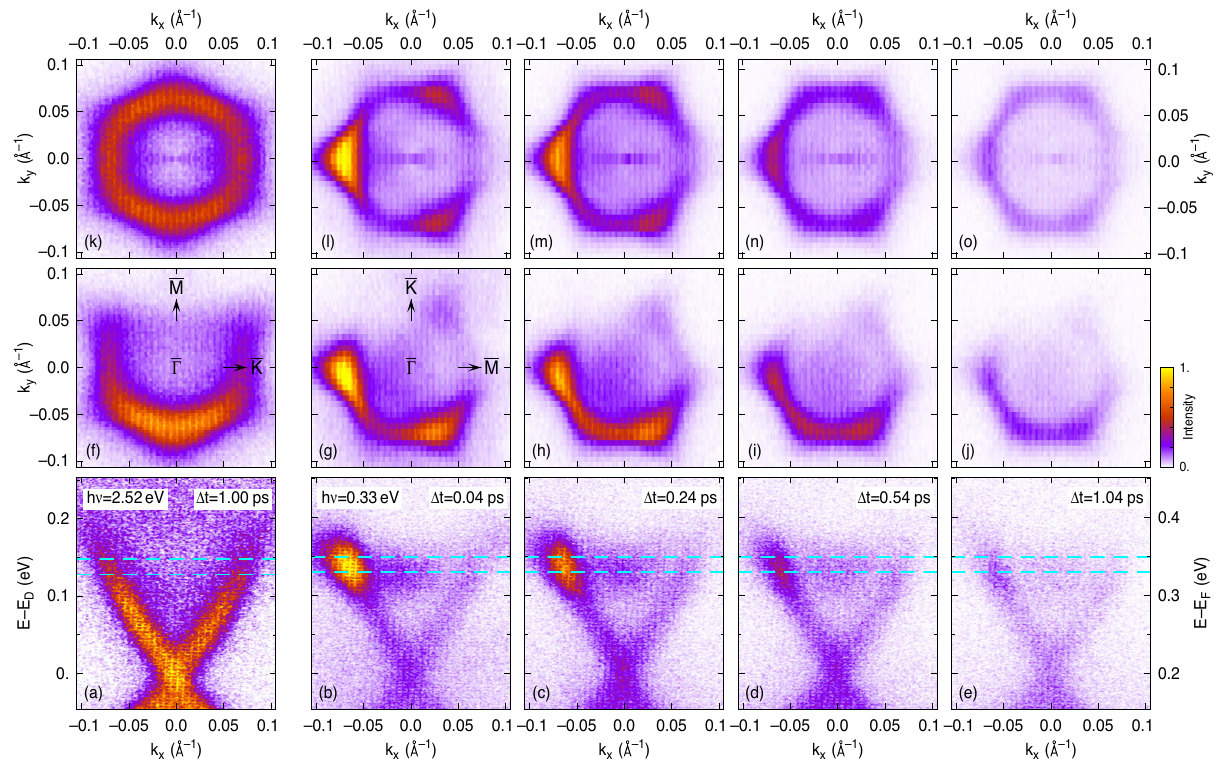
Figure 1. Angle-resolved 2PPE data of Sb 2 Te 3 excited by visible ( h ν = 2.52 eV) and mid-IR ( h ν = 0.33 eV) ¯ Ŵ ¯ K pump pulses. ( a ) E – k x map for 2.52-eV excitation and k x along – at a pump-probe delay of (cid:31) t = 1 ps. ( b – e ) ¯ Ŵ ¯ K For 0.33-eV excitation and k x along – at different pump-probe delays as indicated. ( f – j ) Corresponding k x – k y maps integrated over energy intervals centered at E − E D = 140 meV as is depicted by the cyan dashed lines in ( a – e ). ( k – o ) The same cuts as ( f – j ) but with the intensity corrected for the matrix element of the probe transition and symmetrized by mirroring the data at the k x -axis. For all data, the plane of light incidence is oriented along the k y